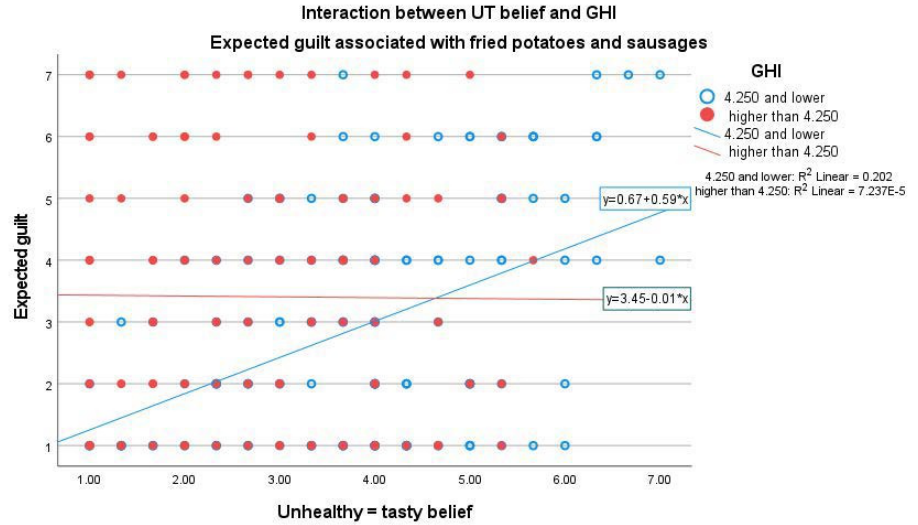
Figure 7. Interaction between UT belief and GHI when rating expected guilt associated with the unhealthy product (fried potatoes and sausages). Linear regression among participants with lower GHI: β = 0.586, p < 0.001, CI (95.0%): 0.385–0.787. Linear regression among participants with higher GHI: β = − 0.013, p = 0.924, CI (95.0%): −